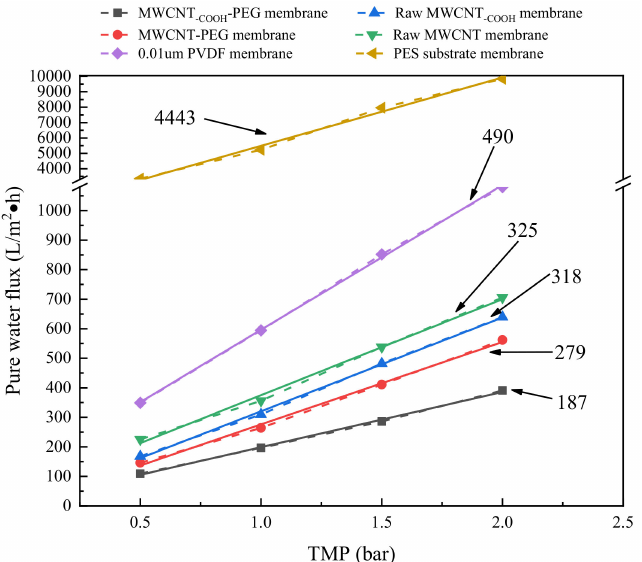
Figure 9. Pure water flux and TMP diagram. In the figure, the dashed line is the connecting line, and the solid line is the linear regression line fitted by experimental data under different membranes. The value beside the line indicates the pure water permeability of the membrane in the unit of L · m · − 2 · h · − 1 · bar − 1